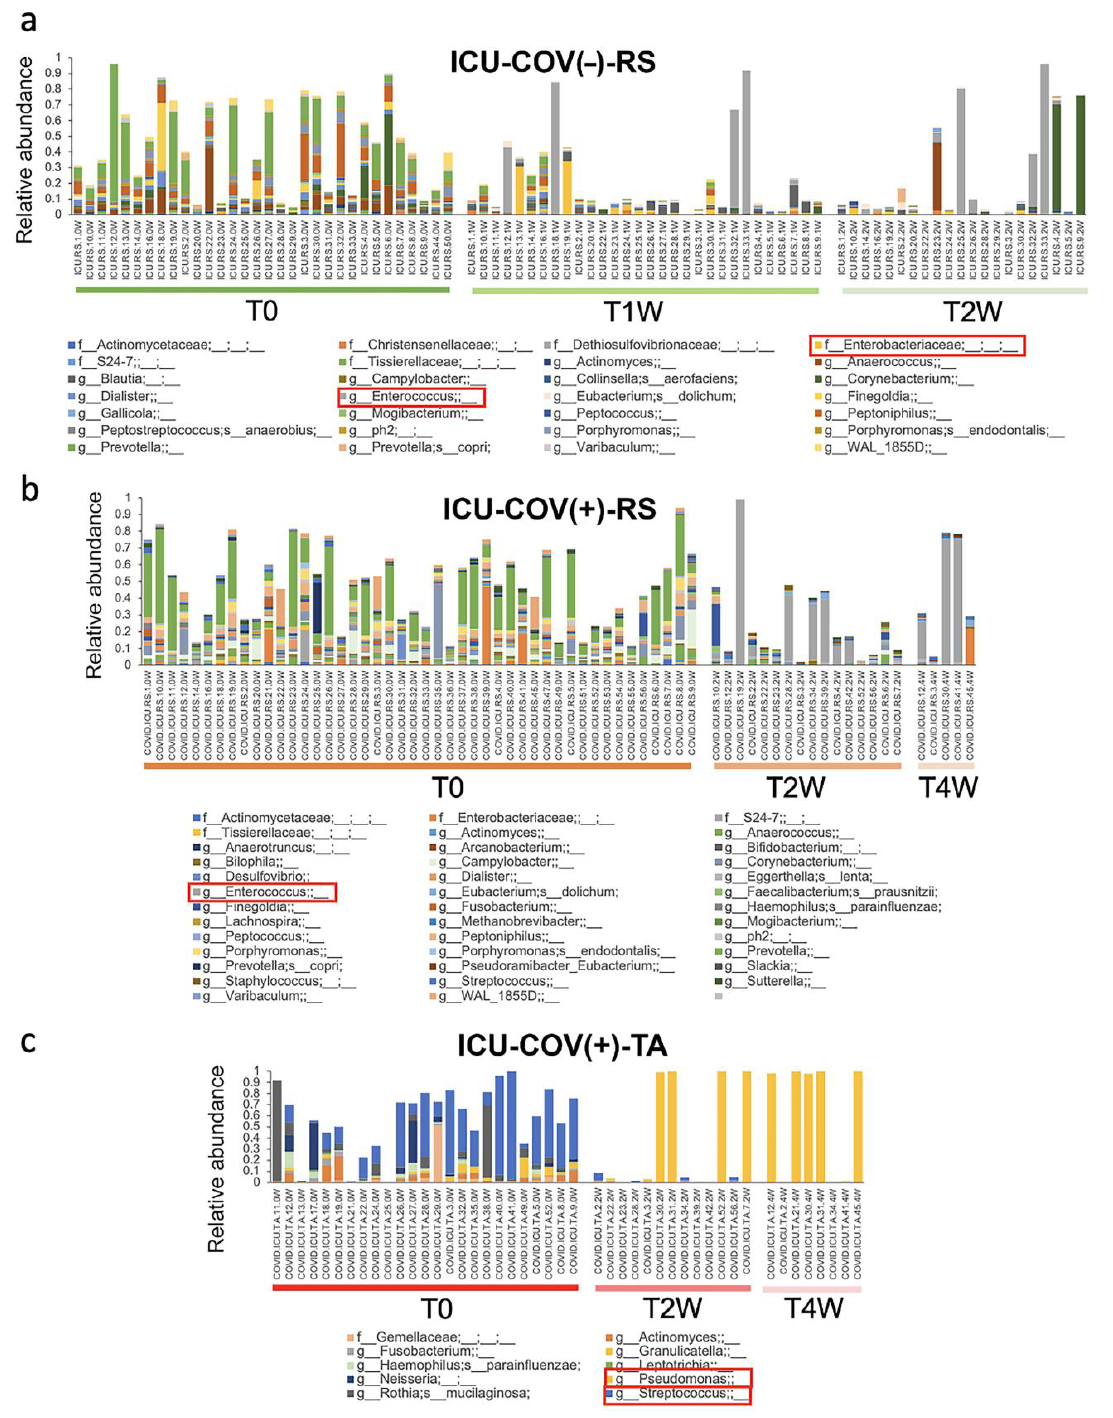
Figure 4. Bacterial taxonomic profiling over time in the ICU. ( a ) Significant changes in the gut microbiome of the ICU-COV( − ) patients at baseline, and 1 and 2 weeks after ICU admission. ( b ) Sig- nificant changes in the gut microbiome of ICU-COV(+) patients at baseline, and 2 and 4 weeks after admission. ( c ) Significant changes in the tracheal aspirates of ICU-COV(+) patients at baseline, and 2 and 4 weeks after ICU admission. Intra-group variability across the three time points was evaluated using MaAsLin2. Only significant results have been plotted (FDR < 0.05). ICU = intensive care unit; COV( − ) = COVID-19-negative; COV(+) = COVID-19-positive; RS = rectal swab; TA = tracheal aspirate. Species inside most affected over time are highlighted in red